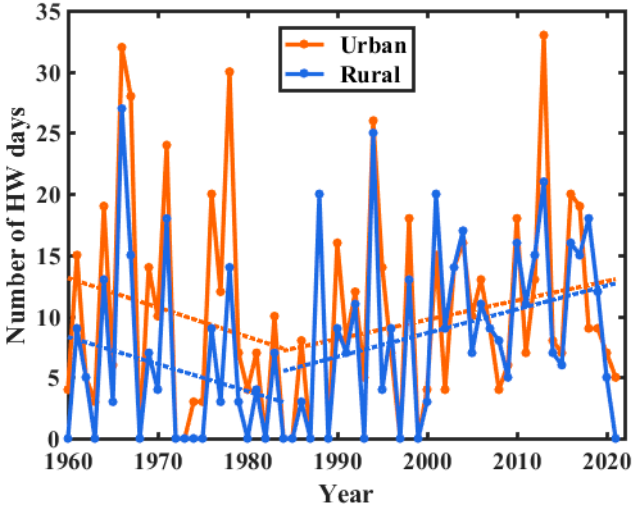
Figure 3. Changes and trends of urban heat wave (HW) days (orange) and rural HW days (blue) from 1960 to 2021. To further elucidate the synoptic weather background during the occurrence of HW days in Nanjing, four favorable weather patterns were identified (Figure 4): (1) Type 1, in